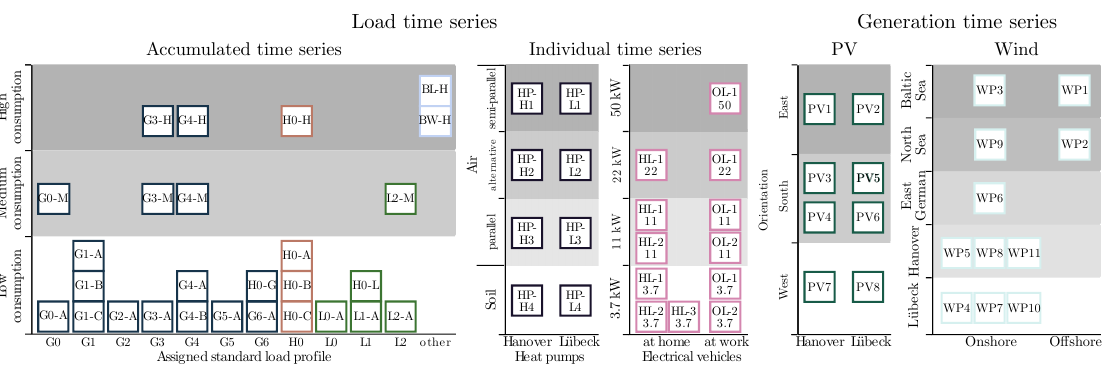
Figure 8. Overview of selected SimBench load and generation time series